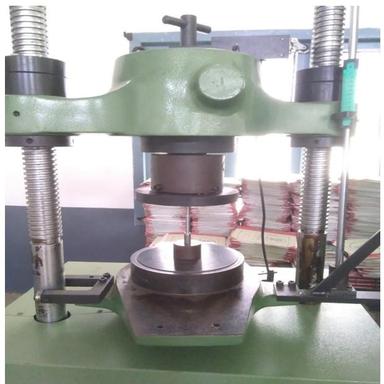
Illustrates the Compaction and ejection equipped machine with 200 kN capacity.